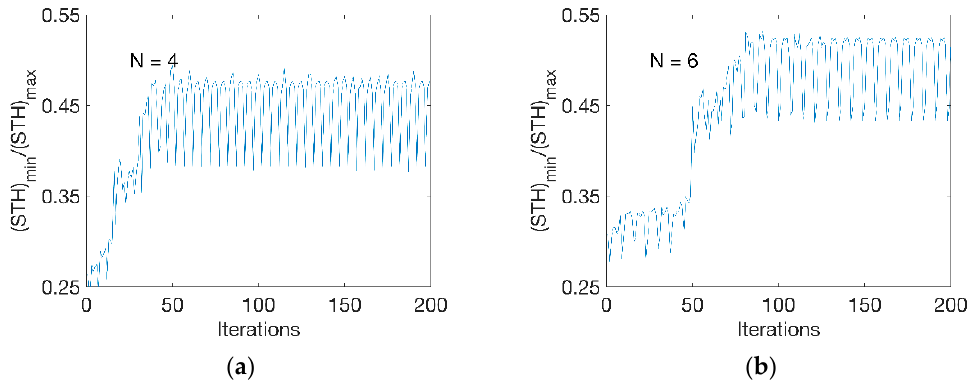
Figure 6. Optimisation process. ( a ) Evolution at N = 4, ( b ) evolution at N = 6.